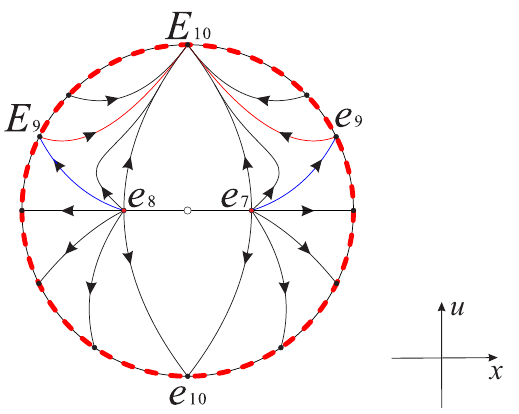
Figure 10. The global phase portrait of system (17) on the invariant surface f + ( x , z , u ) = 0 restricted to the region u ≤ z